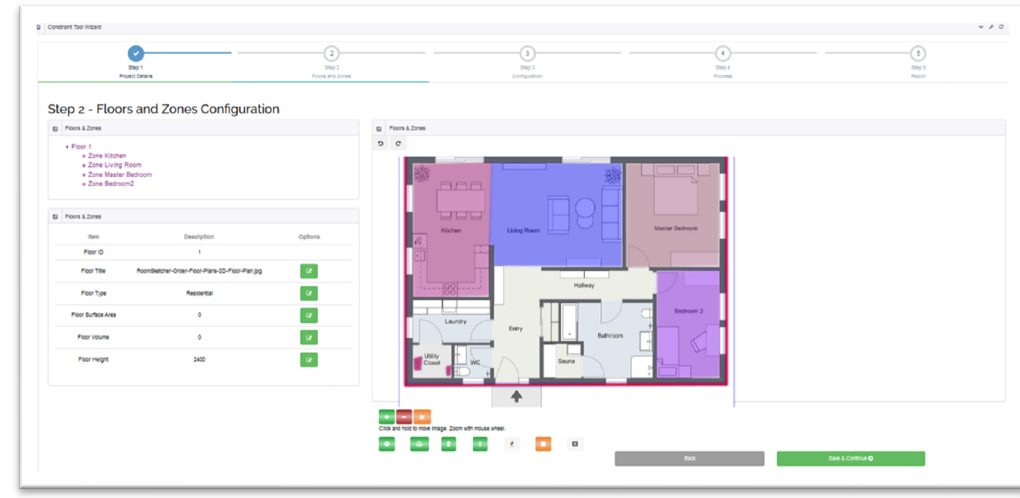
Figure 1. BIMcpd—Constraint Wizard Processing on Zones.